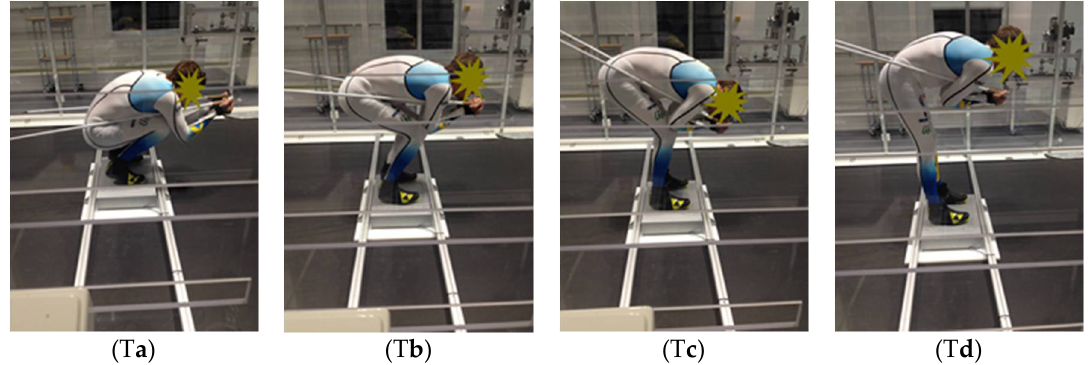
Figure 3. Pictures (T a –T d ) show the skier in the sagittal plane in the different downhill